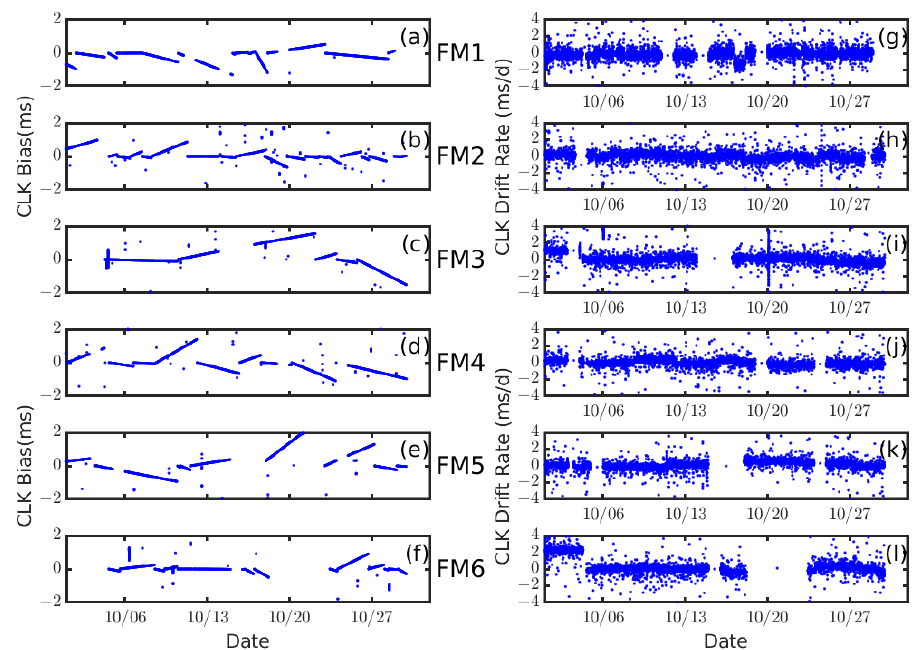
Figure 3. COSMIC-2 FM1-FM6 clock bias and drift time series in October 2019. The left panel ( a – f ) shows COSMIC-2 Clock Bias (millisecond) from Bernese for 6 COSMIC-2 satellites, and the right panel ( g – l ) shows the clock drift rate (millisecond/day, non-smooth, time derivative from clock bias) derived from the clock bias.